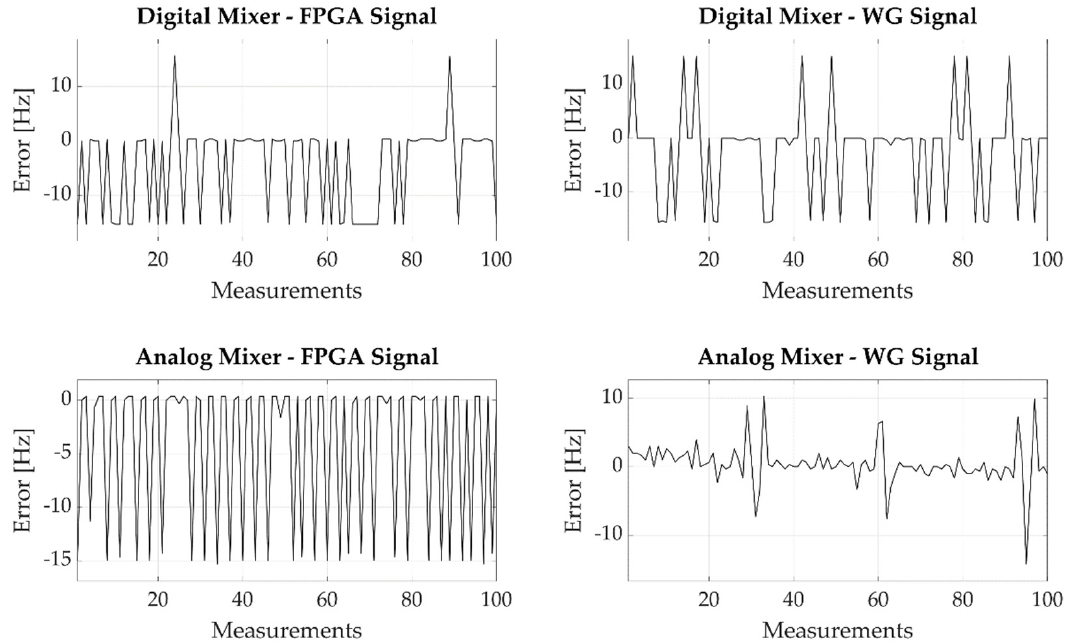
Figure 8. Experimental error observed performing 100 measurements setting the input frequency equal to 9.998 MHz. The four plots show the results obtained by mixing the input signal using the digital or the analog mixer along with the signal generated by the FPGA or by the waveform generator.